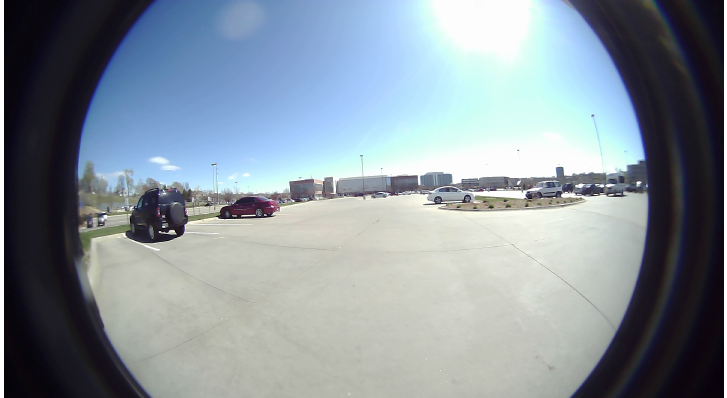
Figure 4. Raw fish-eye image.